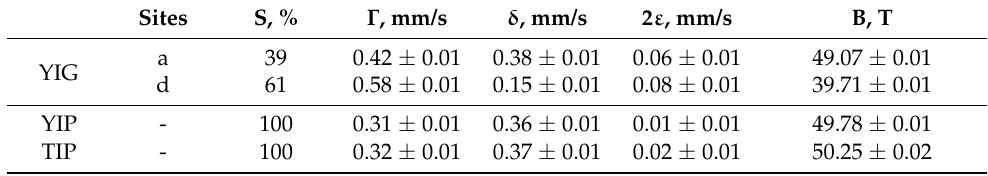
Table 3. Data from bulk sample Mössbauer spectra measured at room temperature: S is the relative area of subspectrum, Γ , δ , ∆ (2 ε ), and B are line width, isomer shift, quadrupole shift, and hyperfine field,